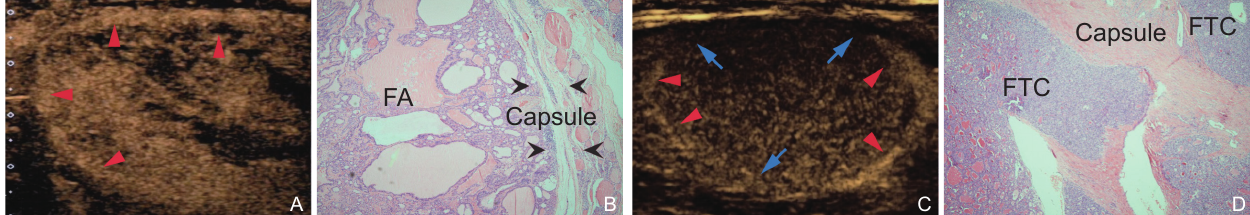
Figure 5 The comparison of the rim enhancement in FA and in FTC. (A) Longitudinal sonography of the left thyroid from a 35-year-old woman. A complete ring enhancement was shown (red arrows); (B) Histopathology appearance of a FA, displaying a regular thin capsule without invasion (HE, original magnification × 4); (C) Transverse sonography of the left thyroid from a 21-year-old woman. An incomplete rim enhancement was shown (red arrows), whereas the anterior and posterior part of rim enhancement was broken (blue arrows); (D) Histological appearance of a minimally invasive FTC,